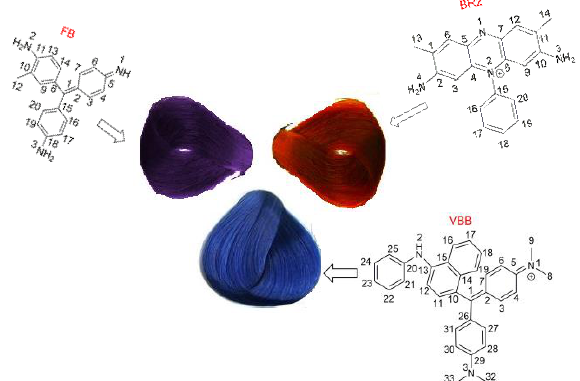
Figure 1. The molecular structures and decorated hair colors of hair dyes fuchsin basic (FB), basic red 2 (BR2) and Victoria blue B (VBB).